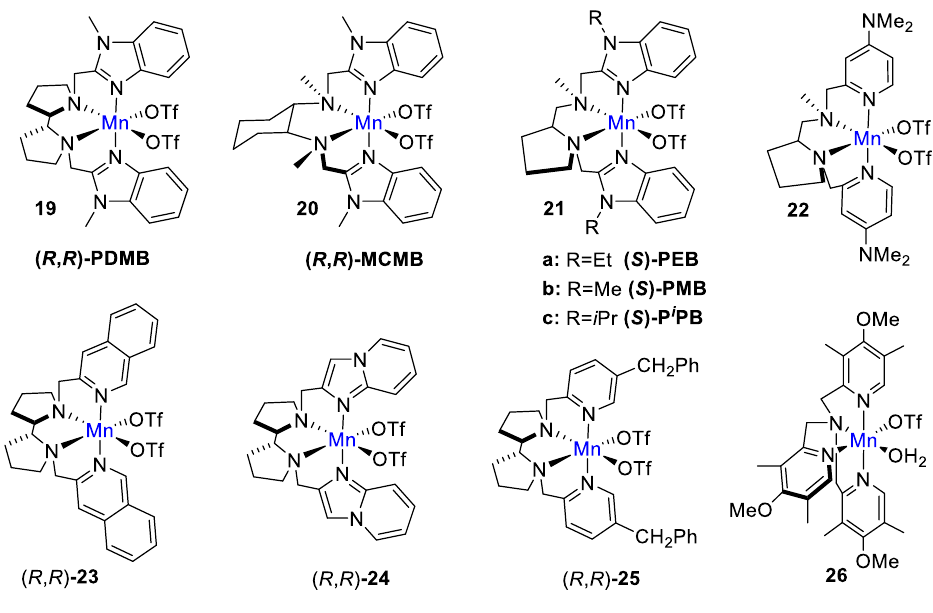
Figure 5. Selected structure of active Manganese complexes.